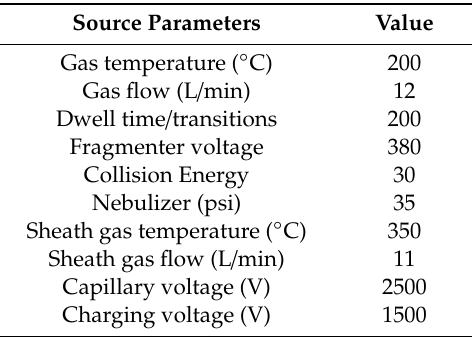
Table 5. The LC–MS / MS working